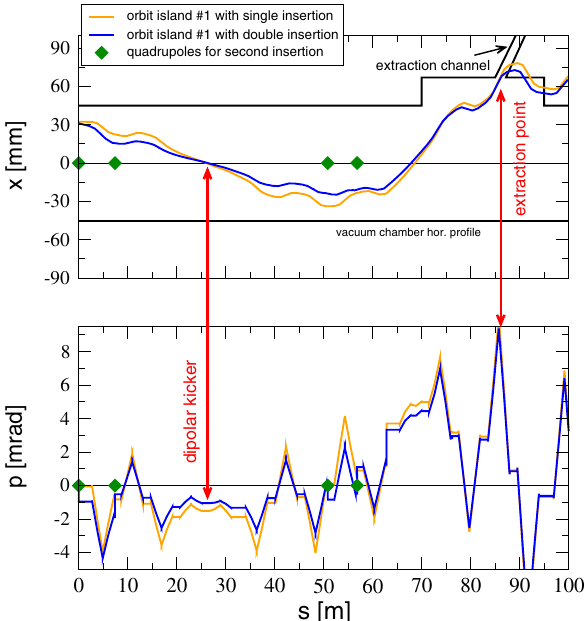
FIG. 6. Example of optics manipulations with four quadrupoles to reduce the strength of the dipole kicker necessary to displace the beam from the central orbit to the one used for performing STE. The initial island orbit with the same insertion optics of Fig. 5 (orange) requires a deflection of 1.5 mrad from the dipole kickers, whereas only 1 mrad would be needed with the proposed